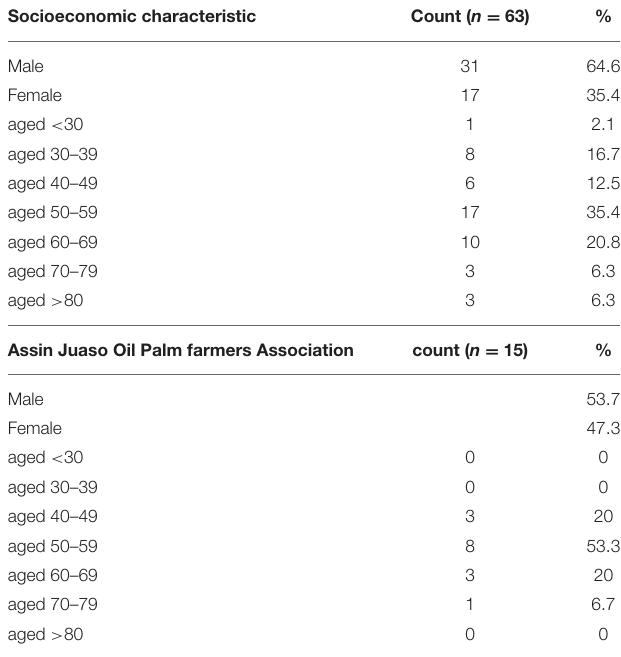
Association), and were able to recount their experience with the TABLE 1 | The distribution of gender and age, across the 63 smallholder farmers we